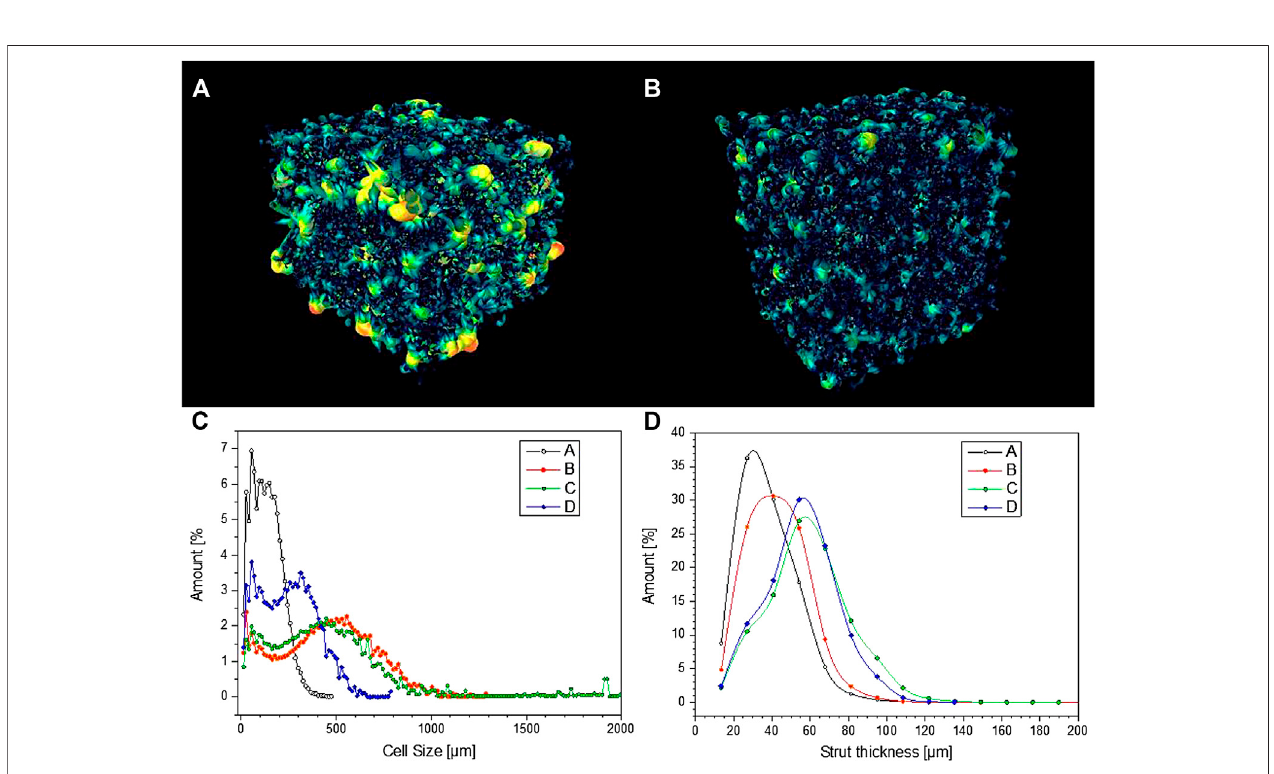
FIGURE 9 | (A, B) pore connectivity of samples C and D ; (C, D) pore size distribution and strut thickness of selected porous Biosilicate ® glass-ceramics.